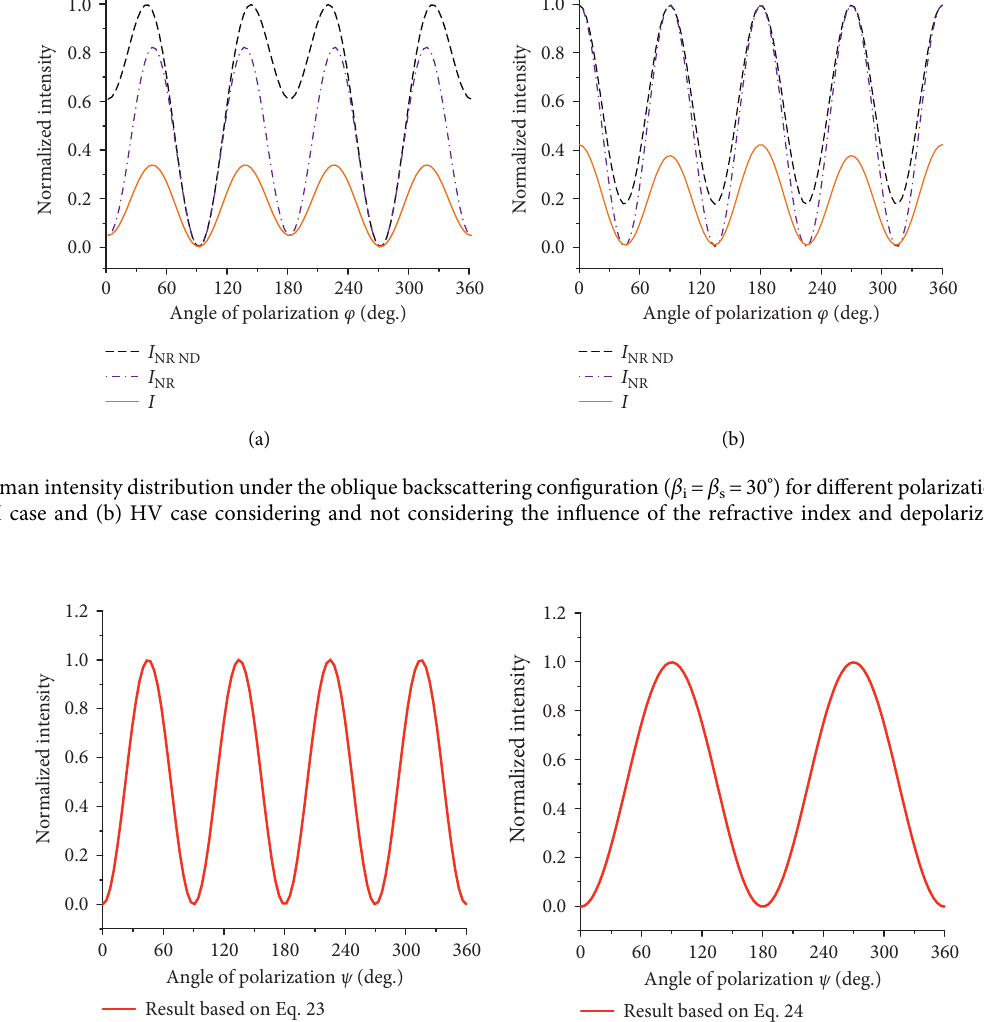
Figure 20: Comparison of the Raman intensities given (a) by (A.3) and (b) by